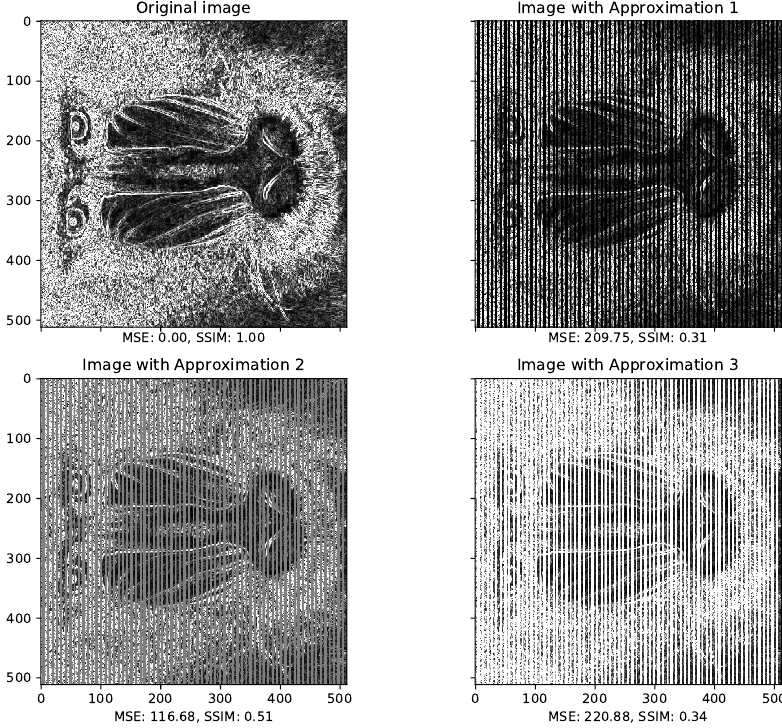
Figure 3. Sobel filter implementation with loop-perforation